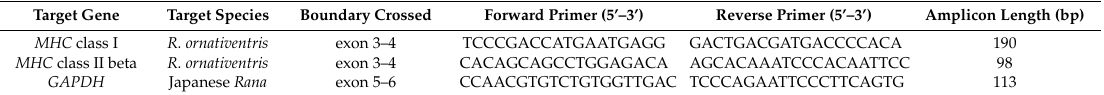
Table 1. Summary of primers used for qPCR in R. ornativentris